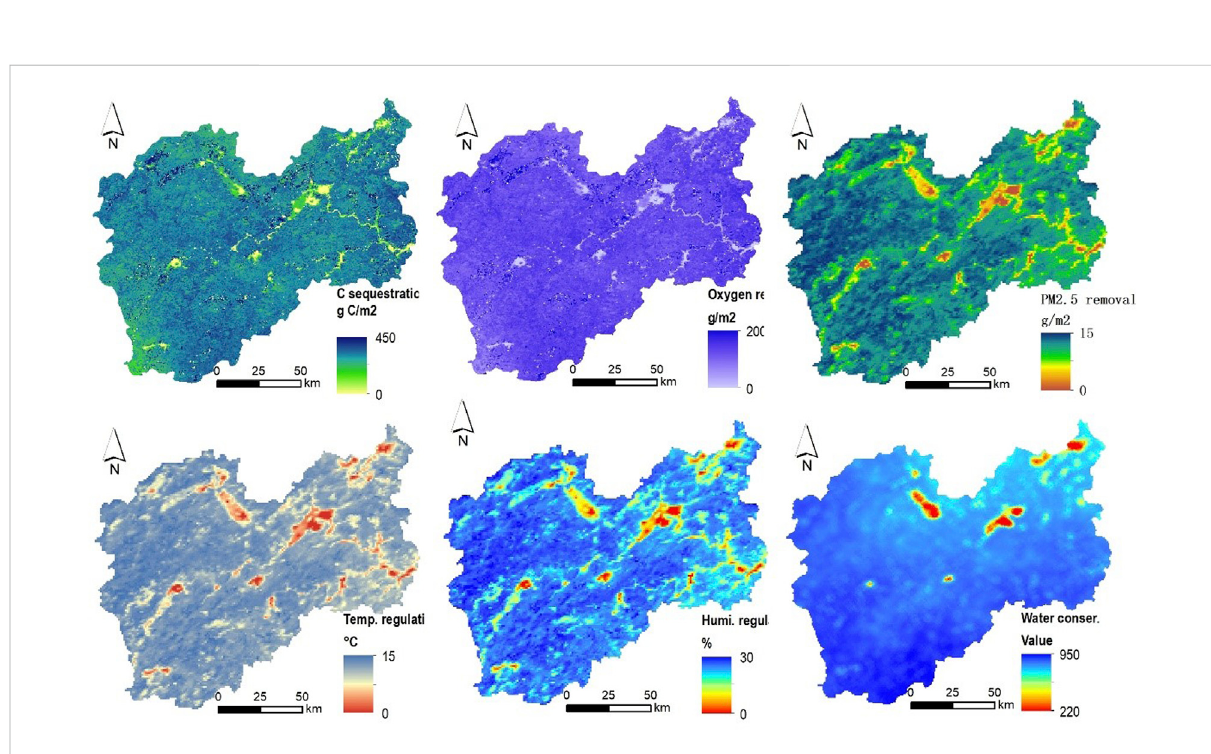
FIGURE 5 Spatial distribution pattern of ecosystem services in Lishui City in